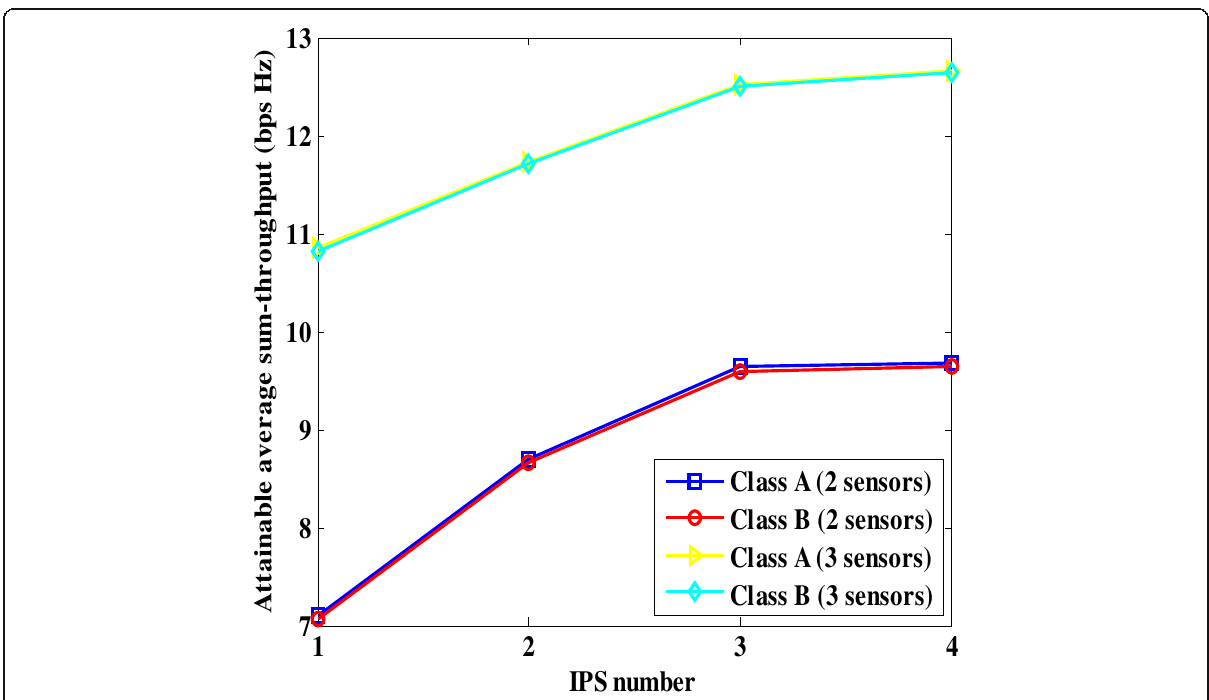
Fig. 10 Attainable average sum-throughput based on equal network